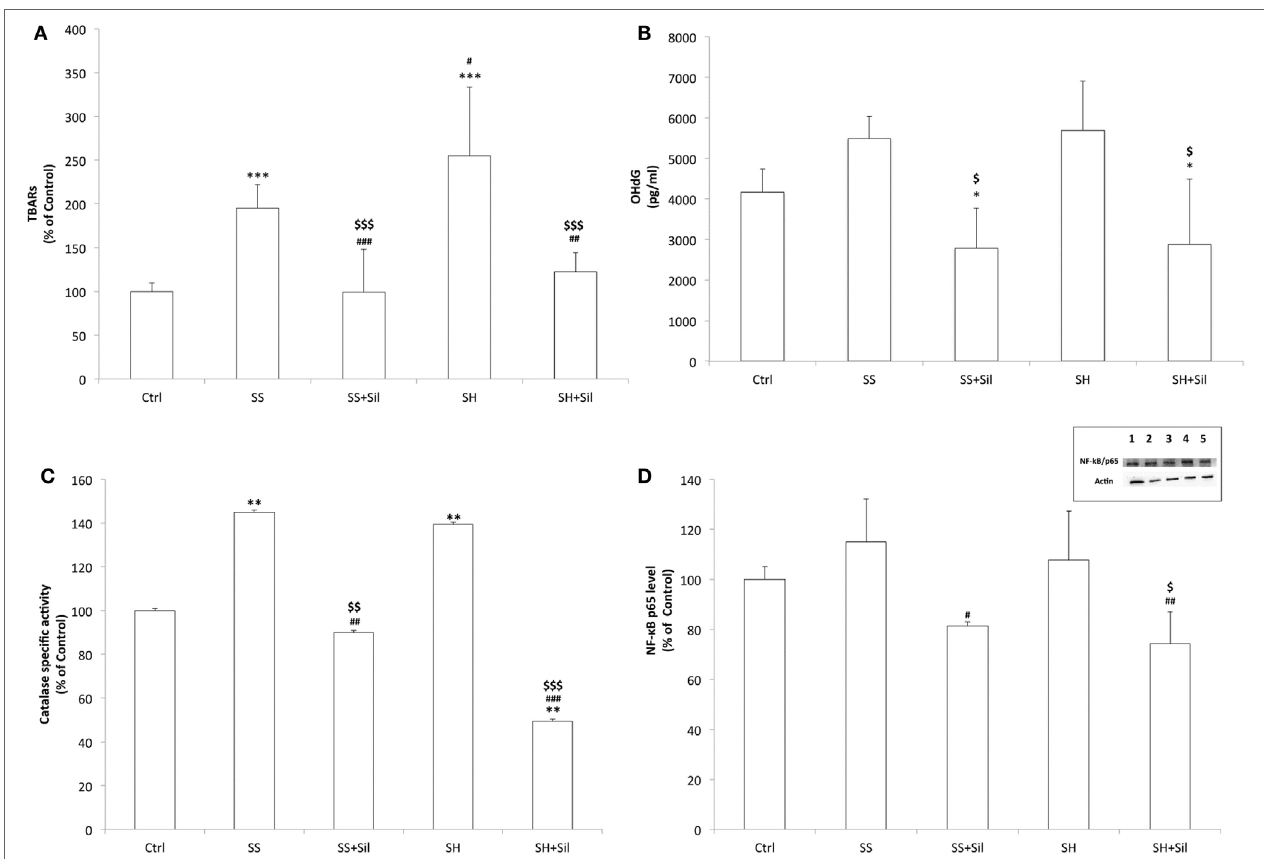
FigUre 7 | Effect of silybin on oxidative stress end-points. Oxidative stress end-points were determined in FaO cells treated under the conditions described in Figure 1 : (a) the intracellular level of MDA (pmol MDA/mL/mg of proteins) by spectrophotometric thiobarbituric acid reactive substances (TBARS) assay. Data are expressed as percentage values with respect to controls and normalized for total proteins. (b) Levels of 8-hydroxy-2-deoxy guanosine (8-OHdG) (pg/mL) released into the culture medium measured by competitive ELISA. (c) Catalase enzymatic activity ( μ moles of decomposed H 2 O 2 /min/mg of proteins) by spectrophotometric assay. Data are expressed as percentage values with respect to controls and normalized for total proteins. (D) Densitometric analysis of nuclear nuclear factor kappa-B (NF- κ B)/p65 evaluated by Western blotting. Data are expressed as percentage values with respect to controls and normalized for β -actin. Immune complexes were visualized using an enhanced chemiluminescence, quantified using a computerized imaging system (Biorad Quantity One 1-D Analysis Software) and expressed as relative optical density (ROD, arbitrary units). Inset: representative image of NF- κ B/p65 immunoreactive bands: control (lane 1), simple steatosis (SS) (lane 2), SS + Sil (lane 3), steatohepatitis (SH) (lane 4), and SH + Sil (lane 5).Values are mean ± SD from at least three independent experiments. ANOVA followed by Tukey’s test was used to assess the statistical significance between groups. Significant differences are denoted by symbols: Ctrl vs all treatments *** p ≤ 0.001, ** p ≤ 0.01, * p ≤ 0.05; SS vs all treatments ### p ≤ 0.001, ## p ≤ 0.01, # p ≤ 0.05; SH vs all treatments $$$ p ≤ 0.001, $$ p ≤ 0.01, $ p ≤